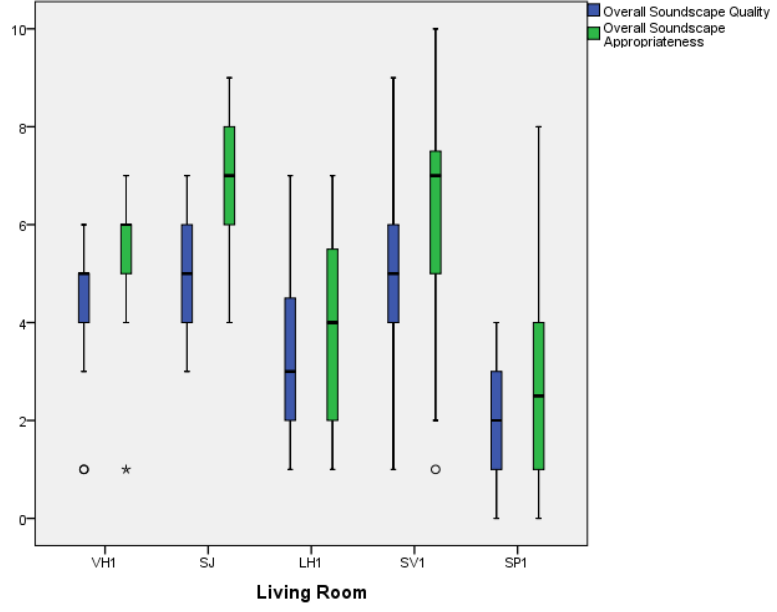
Figure 13. Distributions of Q1 and Q2 scores as a function of the living rooms.